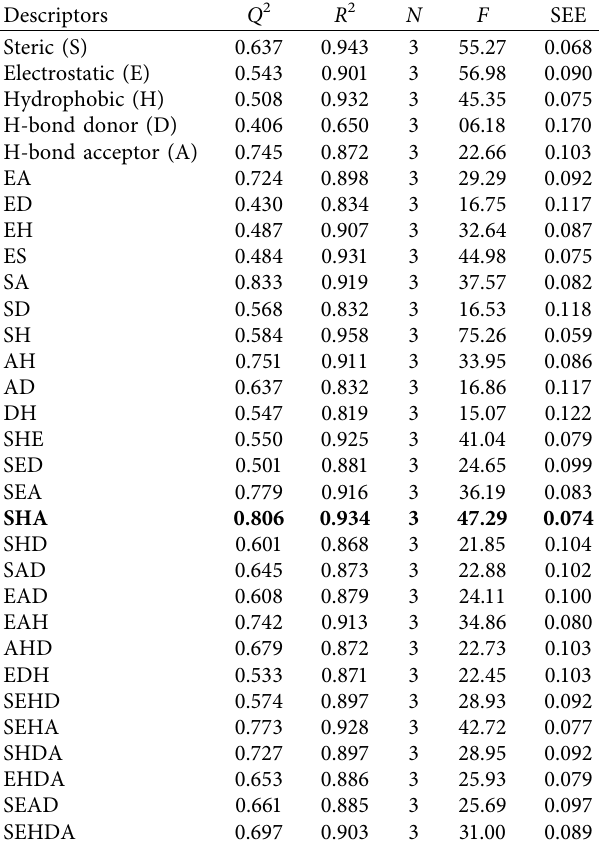
Table 3: Possible CoMSIA